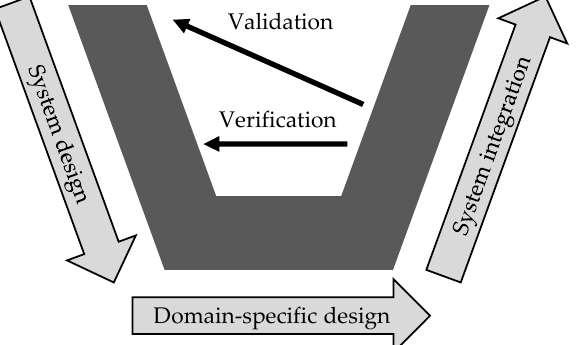
Figure 4. Simplified illustration of the V-Model according to